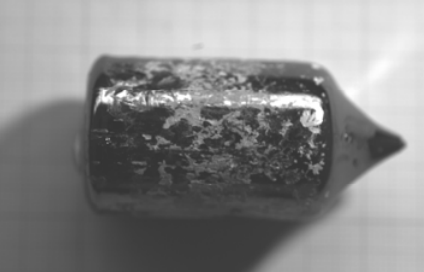
Figure 13. A CdZnTe crystal removed from the crucible: traces of boron oxide are evident on the crystal